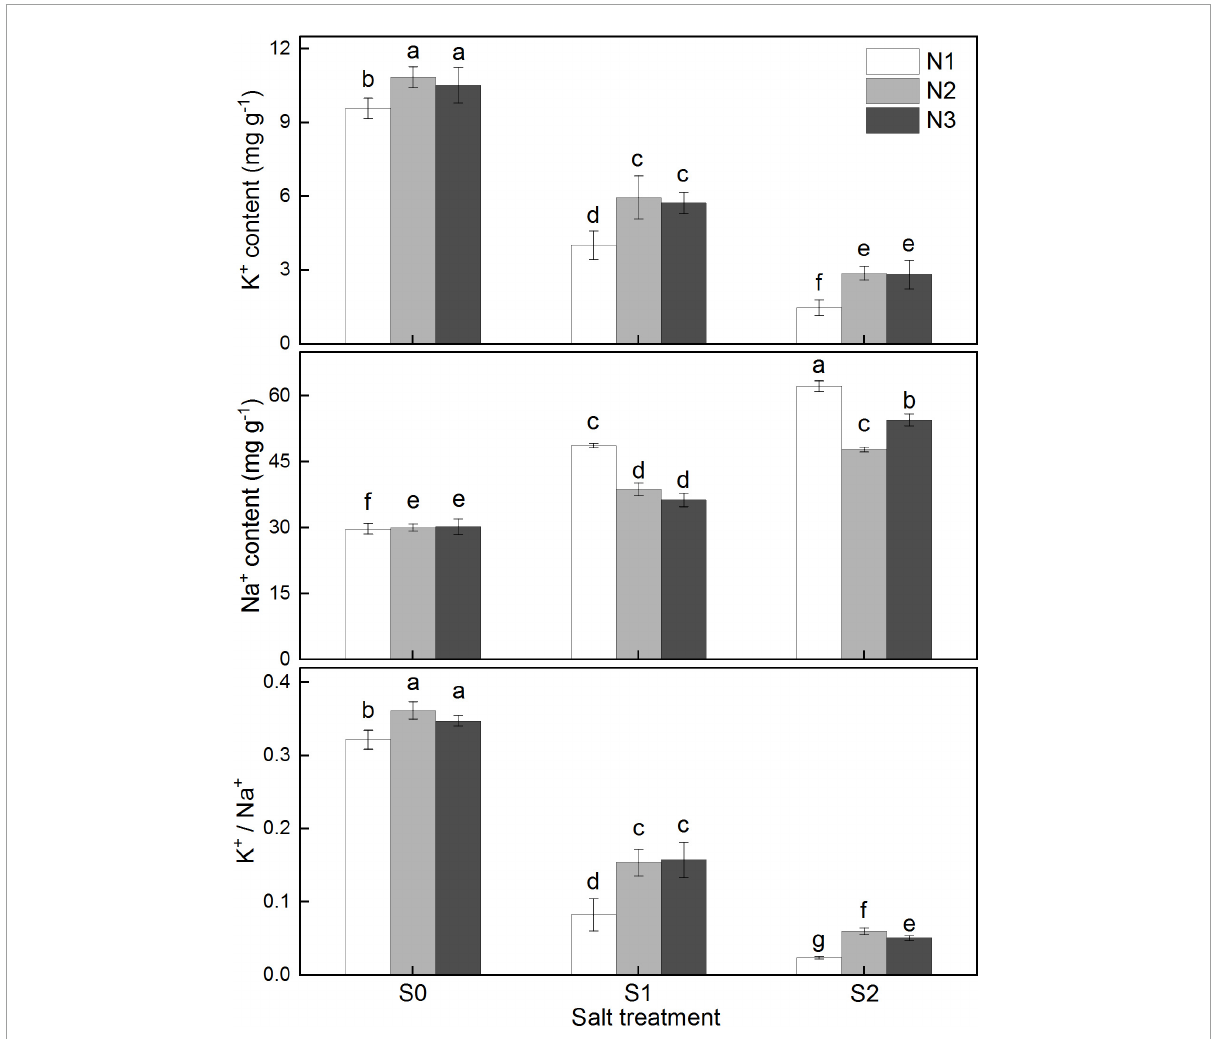
FIGURE3 Effects of different salt concentrations and nitrogen rates on content of K + , Na + , and K + /Na + ratio in rice root at full-ripening stage. S 0 , S 1 , and S 2 denote salt concentrations of 0, 1.5, and 3.0 g kg − 1 NaCl, respectively; N1, N2, and N3 denote nitrogen rates of 210, 300, and 390 kg ha − 1 . The data ( n = 3) are mean values ± SD, calculated from three independent experiments. The different letters indicate significant differences at P <